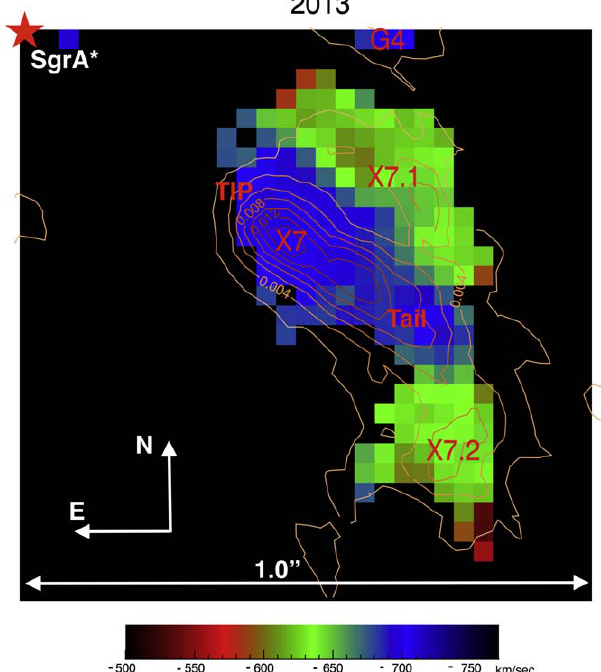
Figure 13. Illustration of X7 ʼ s complex morphology using OSIRIS Br- γ emission as measured in 2013. The color scale illustrates the velocity ( km s − 1 ) , while the contours trace the intensity. The map is constructed using a relatively narrow range of velocities between − 540 and − 730 km s − 1 . The X7 ridge ( tip and tail ) consists of the highest blueshifted velocity gas. Additionally, the X7 complex includes an arc of material to the northeast labeled X7.1 and a clump of gas off of the tail to the south, labeled X7.2. All of these blueshifted Br- γ - emitting features are comoving northward. G4 is included in the slice because of its similar blueshifted radial velocity — but it is unrelated to X7, as its proper motion is in a completely different direction than that of X7 ( Ciurlo et al. 2020 ) . G5, which is also unrelated to X7, is not included in this slice, because of its redshifted radial